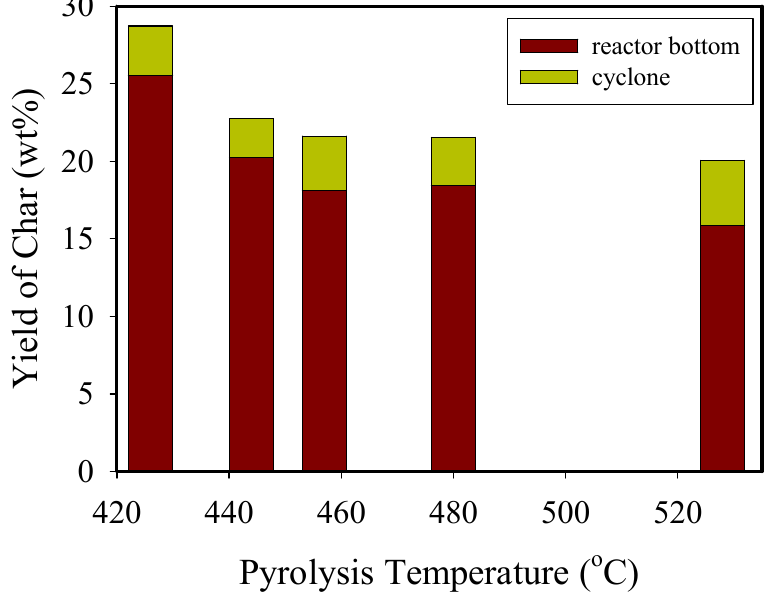
Figure 3. Distribution of char product at different pyrolysis temperature for fast pyrolysis of wood sawdust (0.8 kg/h feeding rate, 15L/min N 2 carrier gas flow rate).